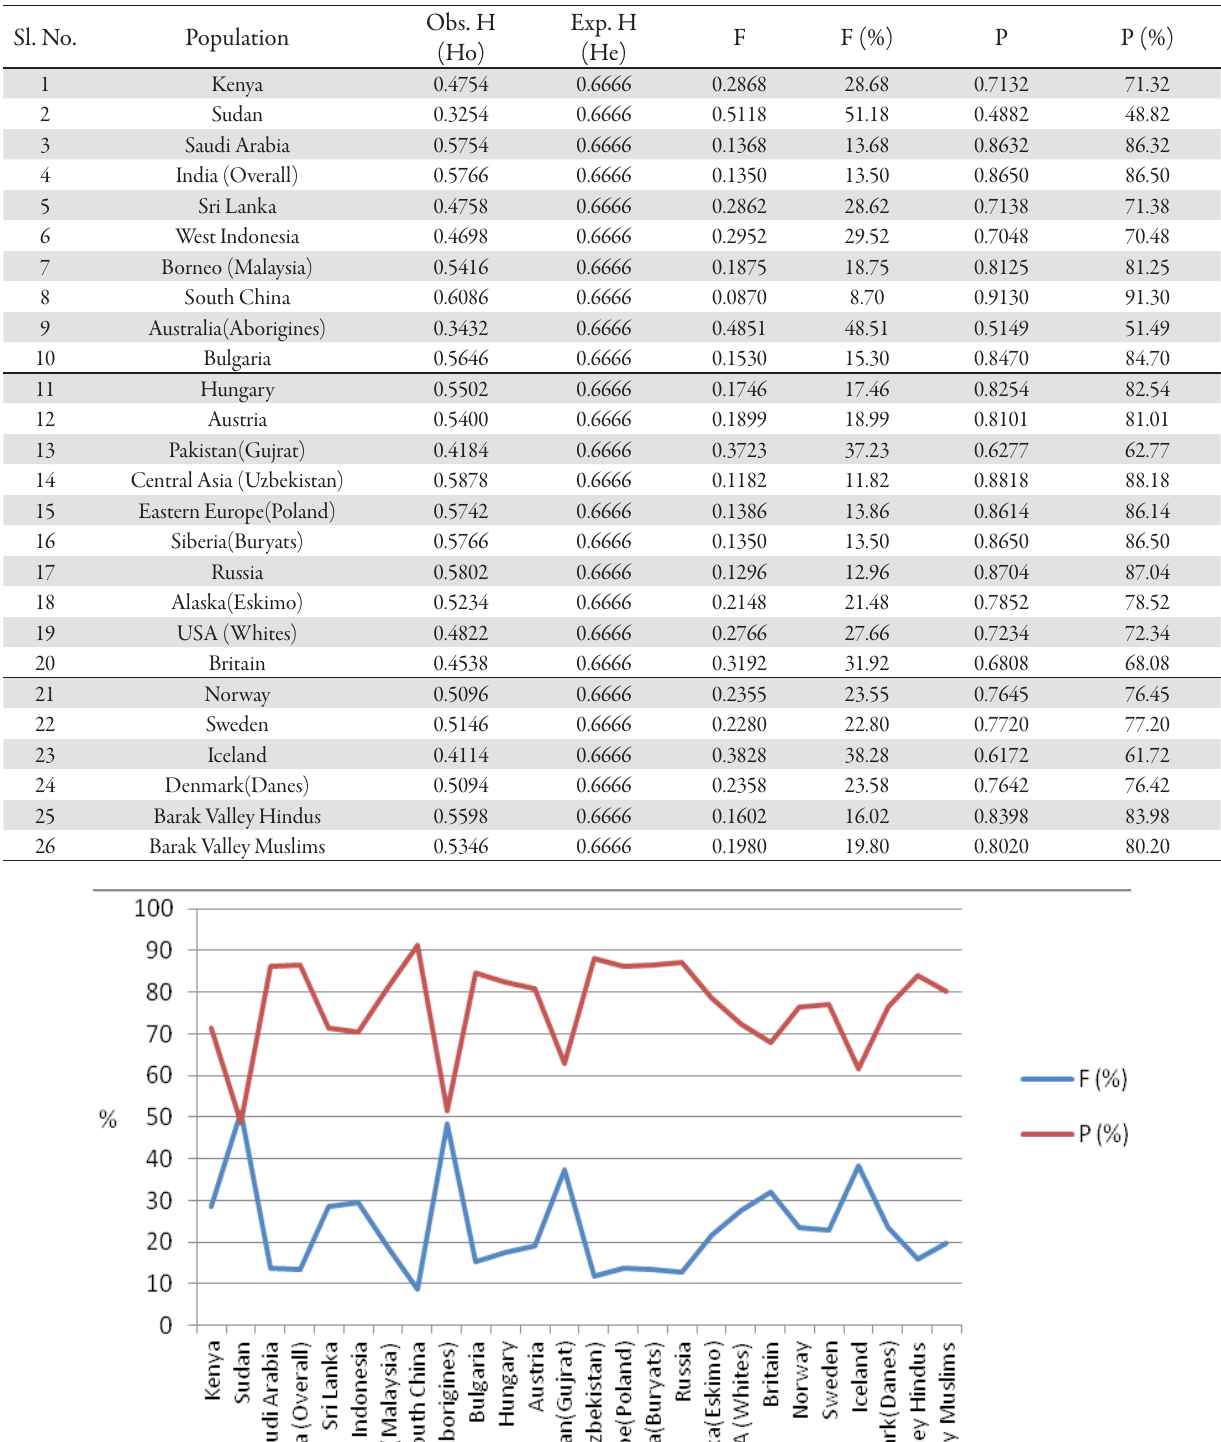
Tab. 2. Estimates of Fixation Index (F) and Panmictic Index (P) for ABO gene in Barak Valley populations vis-a-vis other nations enroute the journey of mankind from Africa Sl. No.